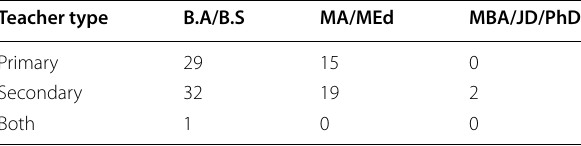
“B.A.” denotes Bachelor of Arts, “B.S.” denotes Bachelor of Science, “MA” denotes Master of Arts, “MEd” denotes Master of Education, “MBA” denotes Master of Business Administration, “JD” denotes Juris Doctor, and “PhD” denotes Doctor of Philosophy. Teachers who reported “both” were teachers who taught at both